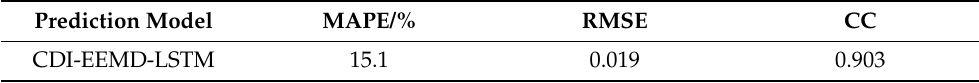
Figure 15. Prediction results of CDI-EEMD-LSTMNN. Table 3. Index of prediction evaluation of CDI-EEMD-LSTM prediction model.